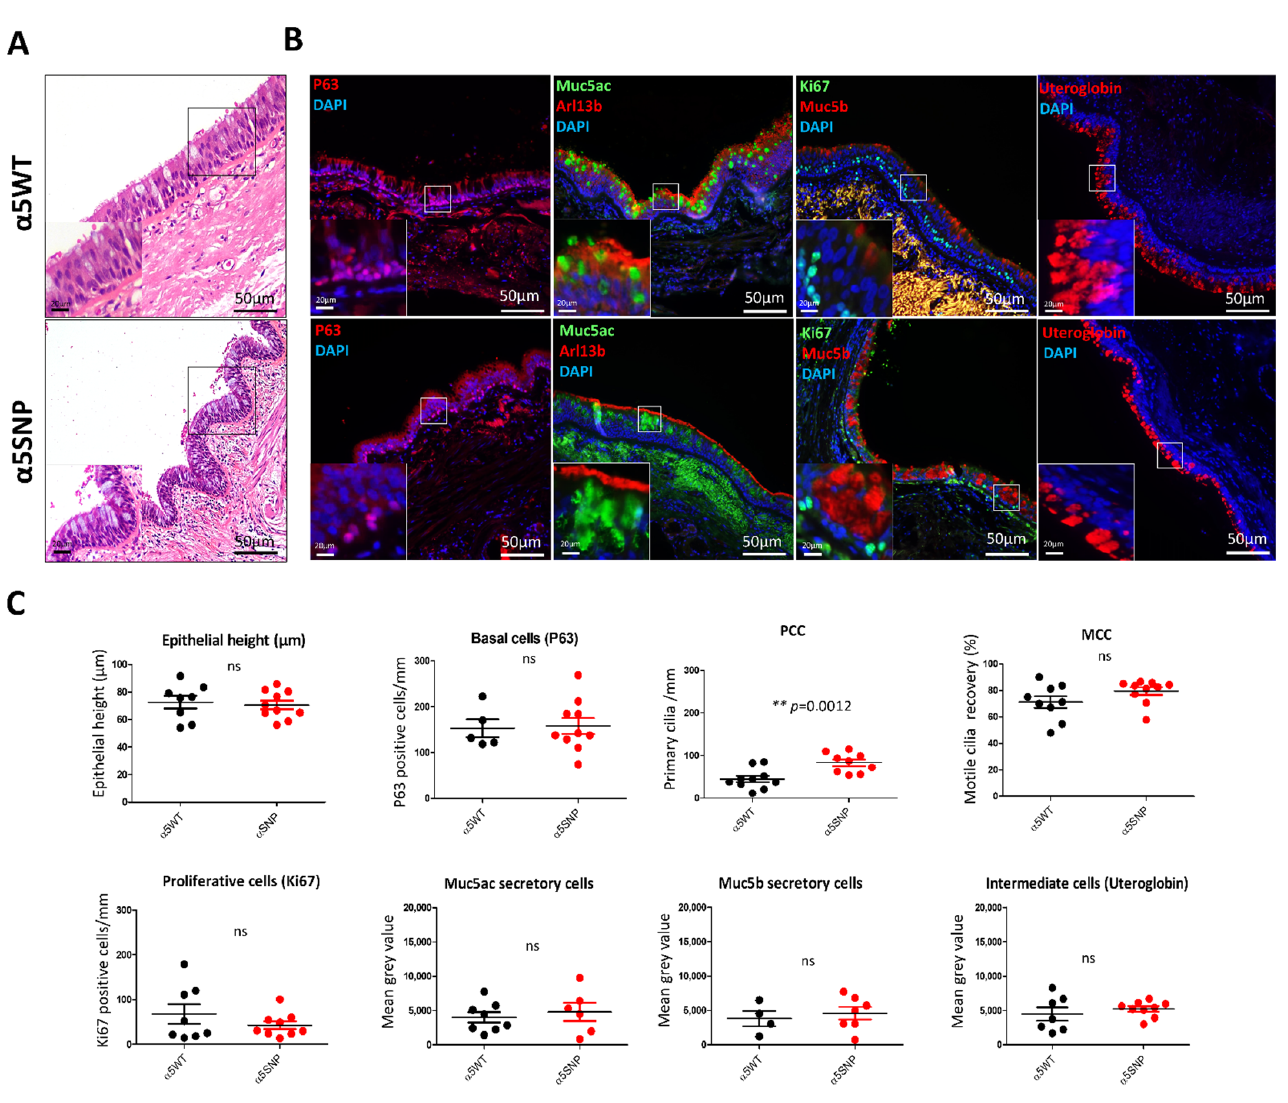
Figure 1. Bronchial epithelial remodeling in rs16969968 ( α 5SNP) COPD patients. ( A ): Hematoxylin and eosin staining showing the epithelial height of α 5SNP and α 5WT COPD patients. ( B ): Examples of the microscopic acquisition of immunofluorescent stainings for basal cells (P63, red), ciliated cells (Arl13b, red), proliferative cells (Ki67, green), mucins secretory cells (Muc5ac, green; Muc5b, red), and intermediate cells (Uteroglobin, red). Nuclei are stained in blue (DAPI). Magnification corresponding to the selected area is represented. ( C ): Dot plots (means with SEM) representing measurements of the epithelial height, the number of basal, proliferative, and primary ciliated cells per mm, motile cilia recovery (%), and the mean grey values of mucins (Muc5ac, Muc5b) and uteroglobin-associated fluorescence of α 5SNP and α 5WT COPD patients. **, p <0.01 α 5WT vs. α 5SNP; ns, non-significant.